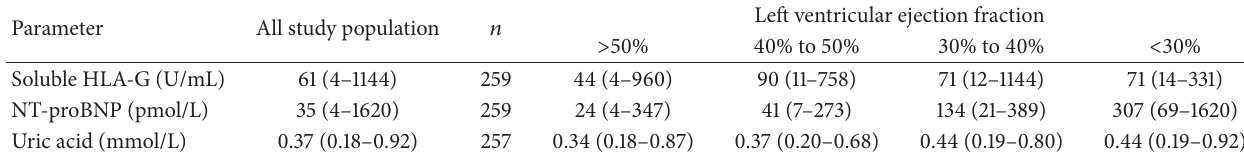
Table 2: The distribution of soluble HLA-G (U/mL), NT-proBNP (pmol/L), and uric acid (mmol/L) according to the left ventricular ejection fraction (median, range).